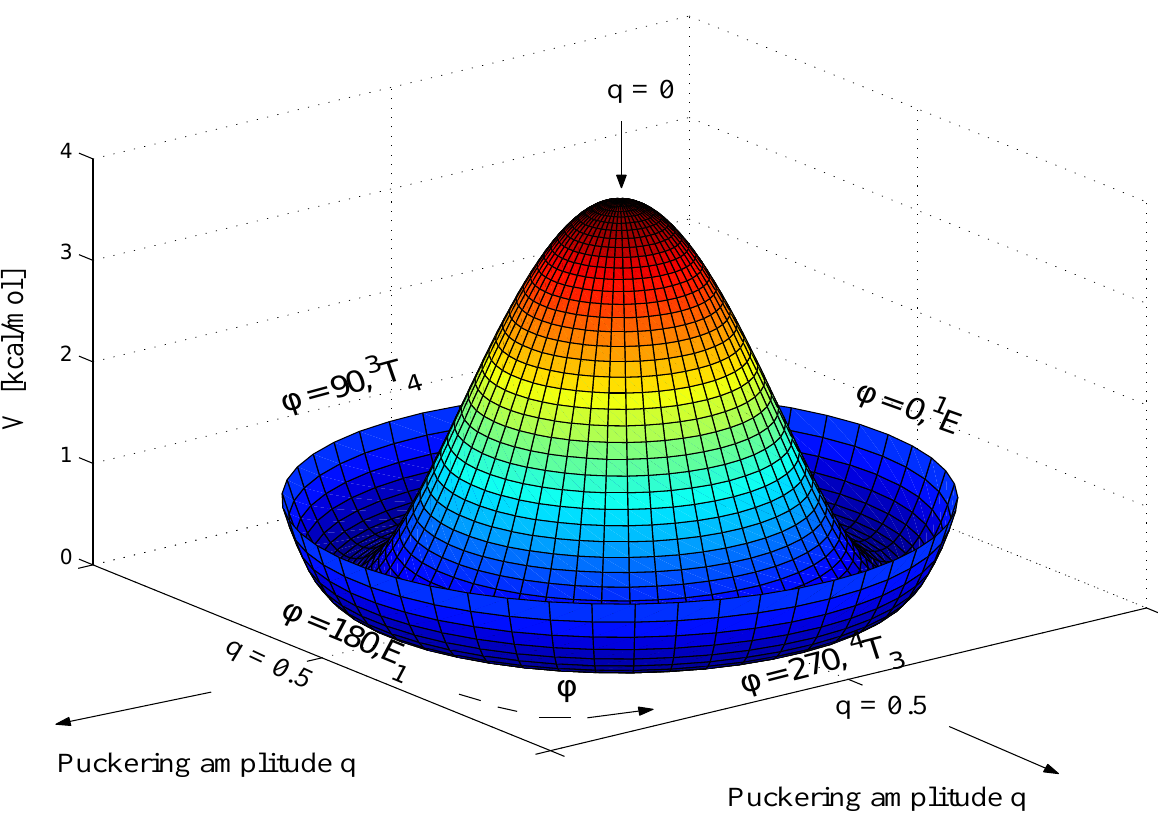
Figure 2: Perspective drawing of the three-dimensional conformational energy surface V(q, φ ) of THF. The planar form with q = 0 is located at the maximum. The direction of radial coordinate q and the angular coordinate φ is